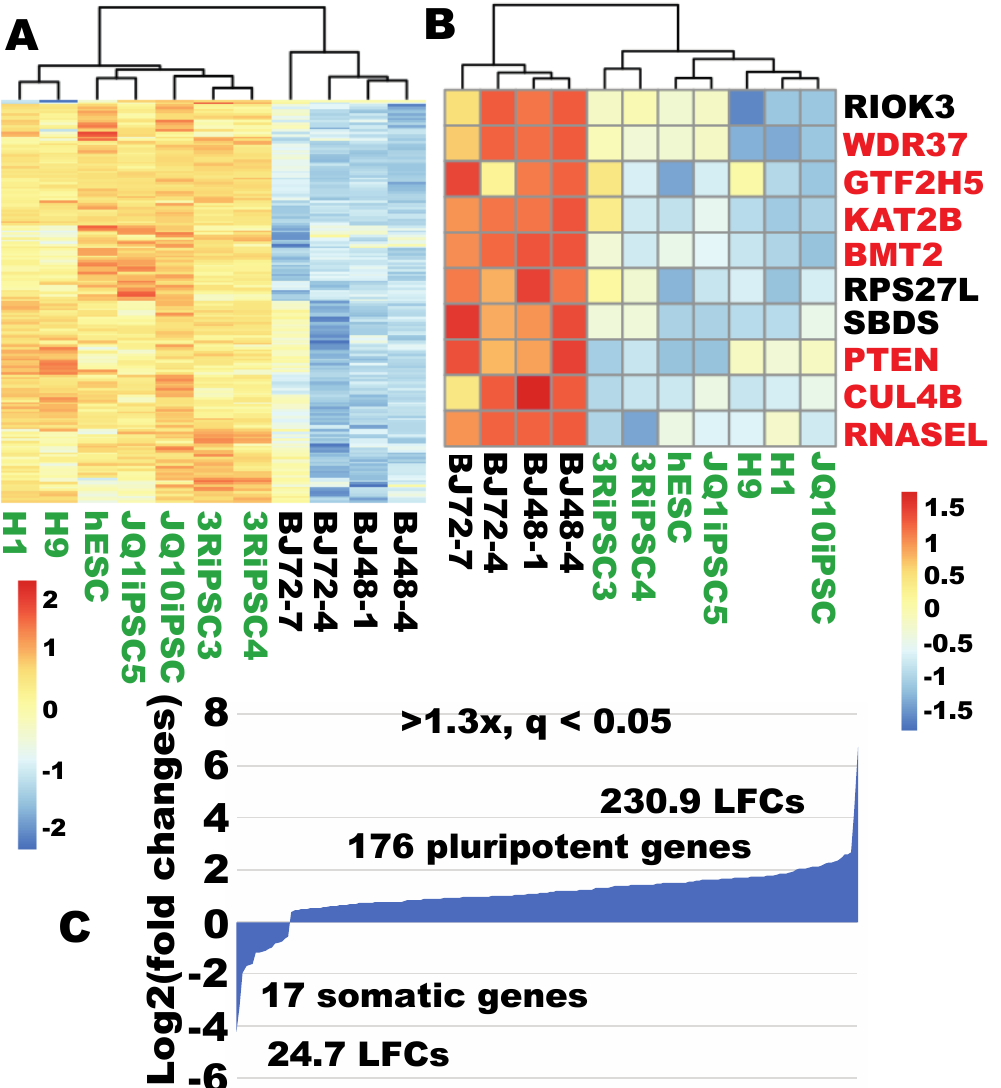
Figure 8. Ribosome biogenesis was more robust in human iPSCs than in fibroblasts. ( A ) Out of 298 RB genes, 176 were significantly enriched in human iPSCs compared to fibroblasts ( > 1.3 × , q < 0.05). ( B ) Out of 298 RB genes, only 10 were enriched in human fibroblasts compared to iPSCs ( > 2 × , q < 0.01). ( C ) Quantification of expression enrichment of the RB genes in iPSCs relative to fibroblasts. LFC, log2 fold changes.